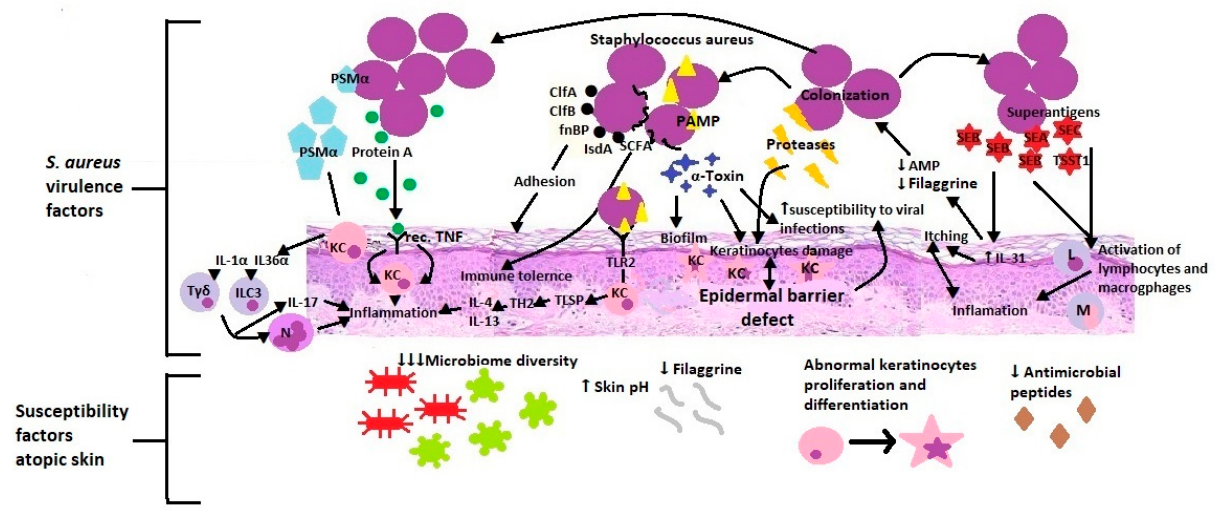
Figure 3. S. aureus virulence factors & atopic skin susceptibility factors. PSM α (Phenol-soluble modulins alpha), KC (Keratinocytes), IL-1 α (Interleukin 1 α ), IL-36 α (Interleukin 36 α ), T γδ (Gamma delta T cells), ILC3 (Type 3 innate lymphoid cells), IL-17 (Interleukin 17), N (Neutrophils), Rec. TNF (receptors for Tumor necrosis factor), ClfA (Clumping factors A), ClfB (clumping factors B), fnBP (Fibronectin-binding protein), IsdA (Iron-regulated surface determinant A), SCFA, PAMP (Pathogen-associated molecular patterns), TLR2 (Toll-like receptor 2), Th2(T helper cells 2), IL-4 (Interleukin 4), IL-13 (Interleukin 13), AMP (Antimicrobial peptides), IL-31 (Interleukin 31), SEA (Staphylococcal enterotoxin A), SEB (Staphylococcal enterotoxin B), SEC (Staphylococcal enterotoxin C), TSST1 (toxic shock syndrome toxin 1), L (Lymphocytes), M (Macrophages).